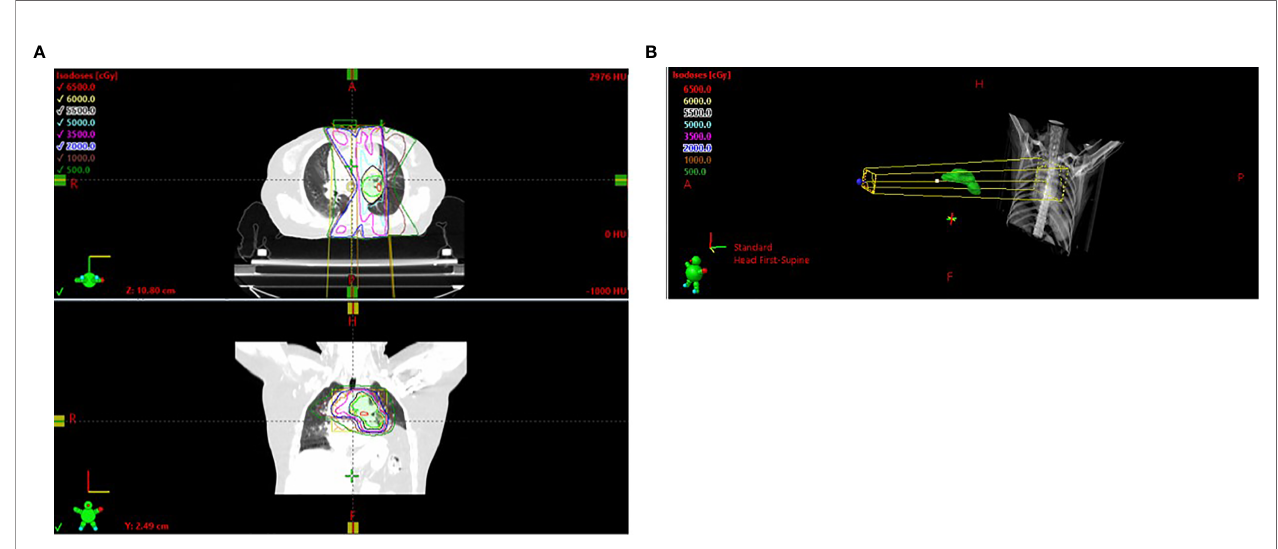
FIGURE 2 | (A) Radiation fi eld. (B) DRR in the AP. DRR, digitally reconstructed radiograph; AP, anterior –